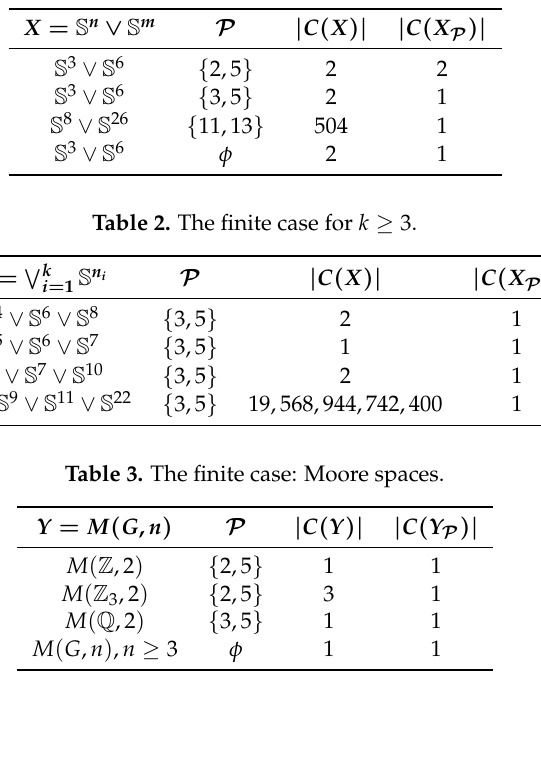
Table 1. The finite case.